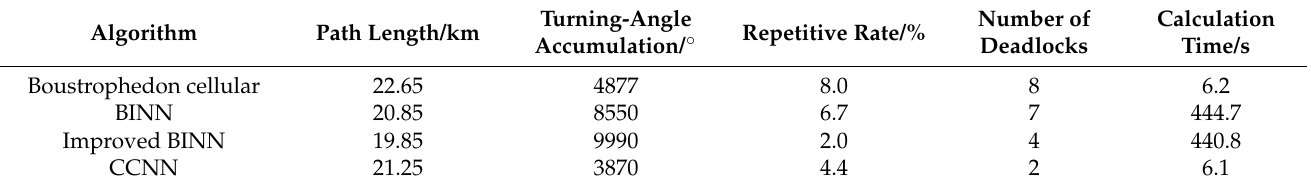
Figure 14. Generated path of different algorithms in the real-world environment: ( a ) Boustrophedon cellular algorithm. ( b ) BINN algorithm. ( c ) Improved BINN algorithm. ( d ) CCNN algorithm. Table 4. Simulation results of different algorithms in the real-world environment.